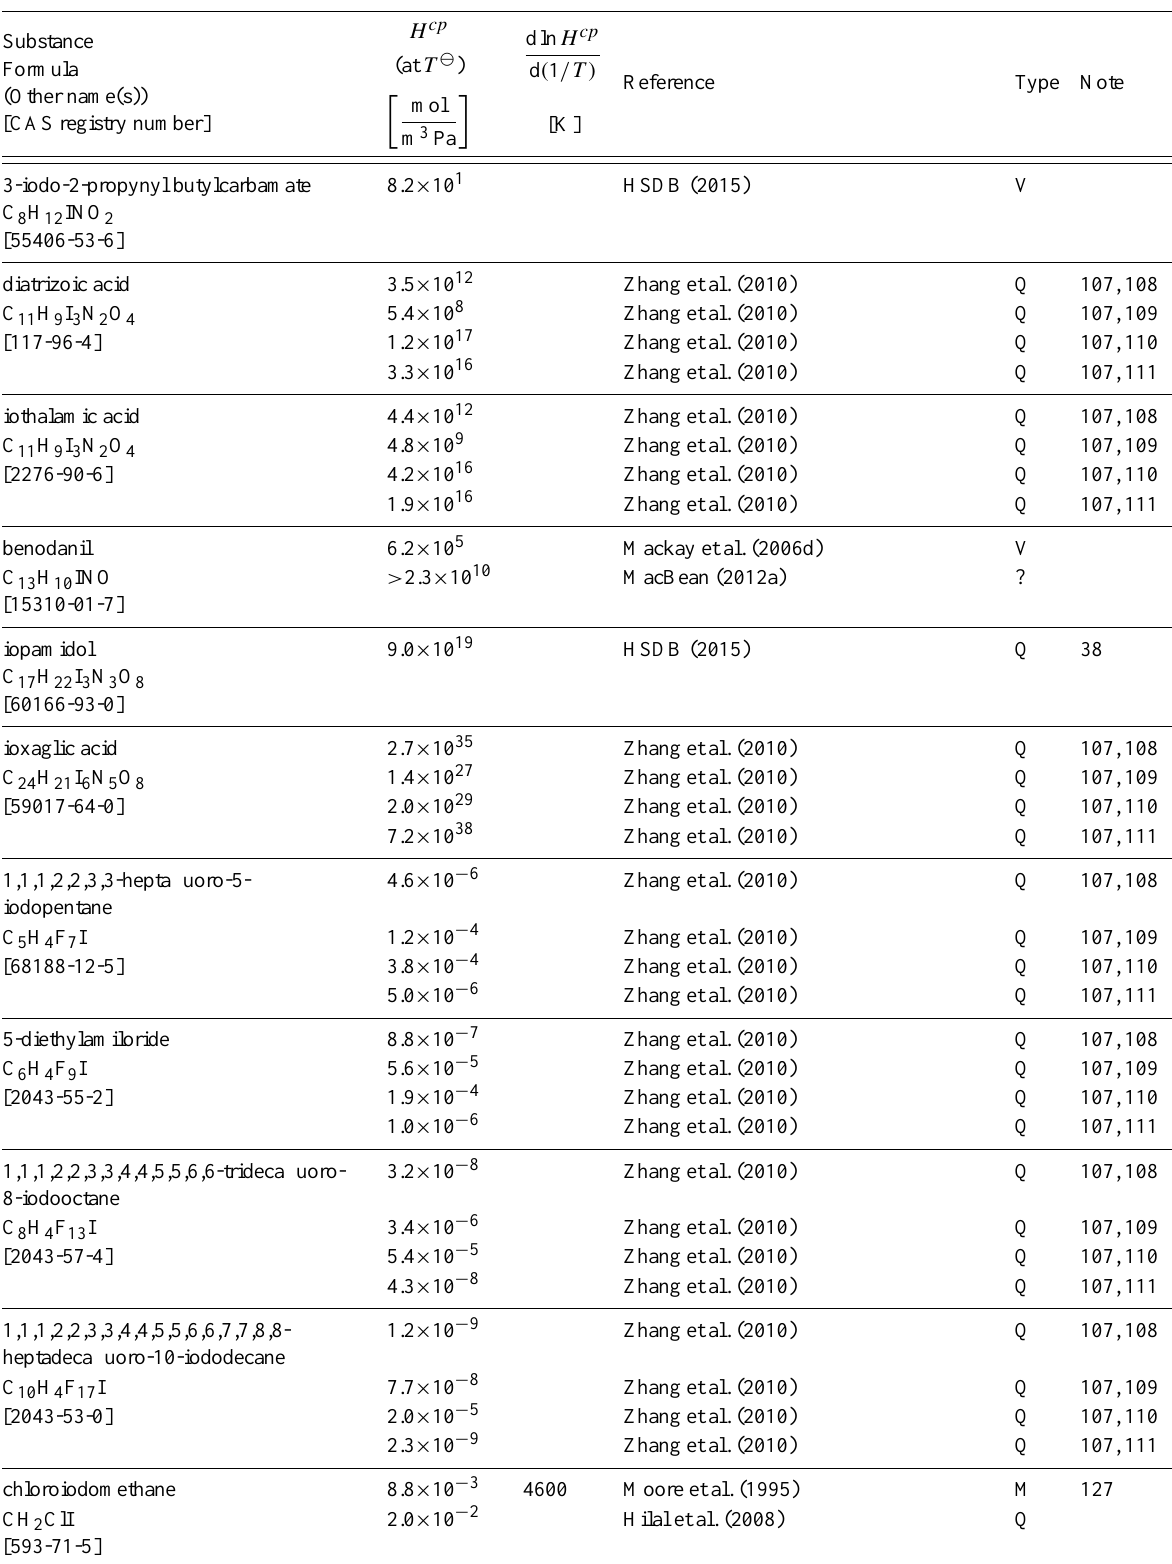
Table 6: Henry’s law constants for water as solvent